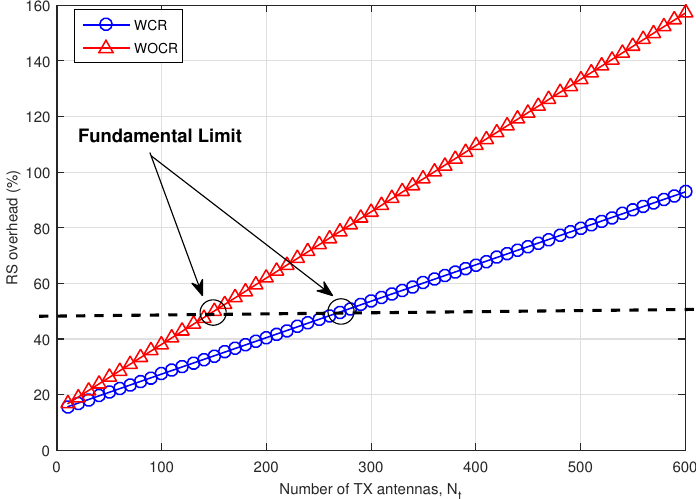
Figure 2. reference signa (RS) overhead (%) versus the number of transmitter (TX) antennas, N t for 5 ms coherence